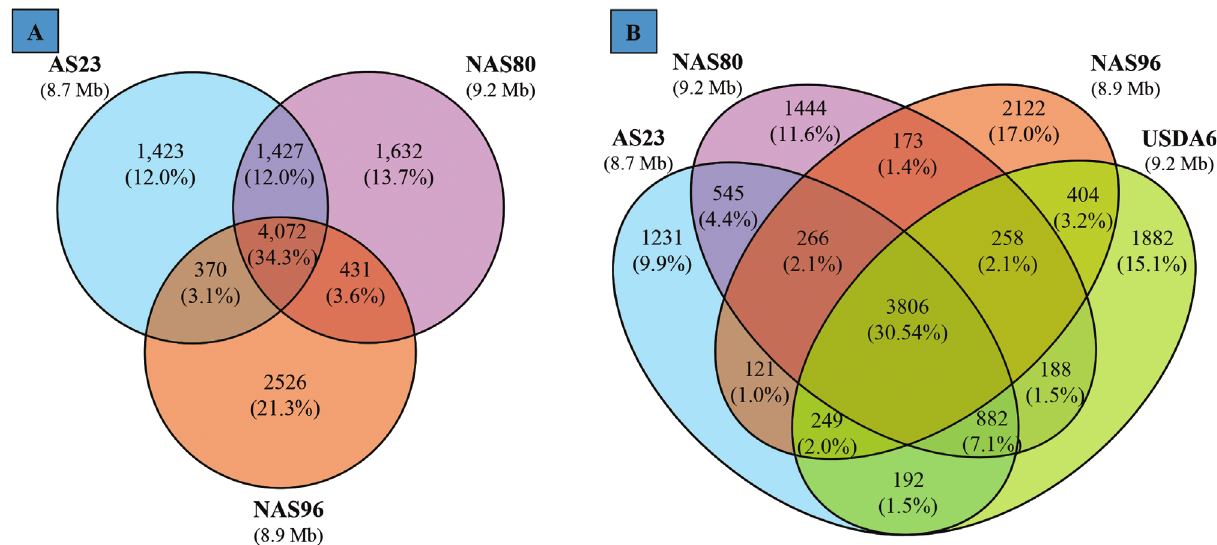
Figure 3 - Venn diagrams comparing the genes identified in the genomes of Bradyrhizobium strains. (A) AS23, NAS80, and NAS96. (B) AS23, NAS80, NAS96, and USDA 6. Each genome is represented by a circle (A) or ellipse (B), and the numbers of shared and unique genes are shown by overlapping and non-overlapping parts, respectively. The proportion of total genes represented by each area of the diagram is shown in